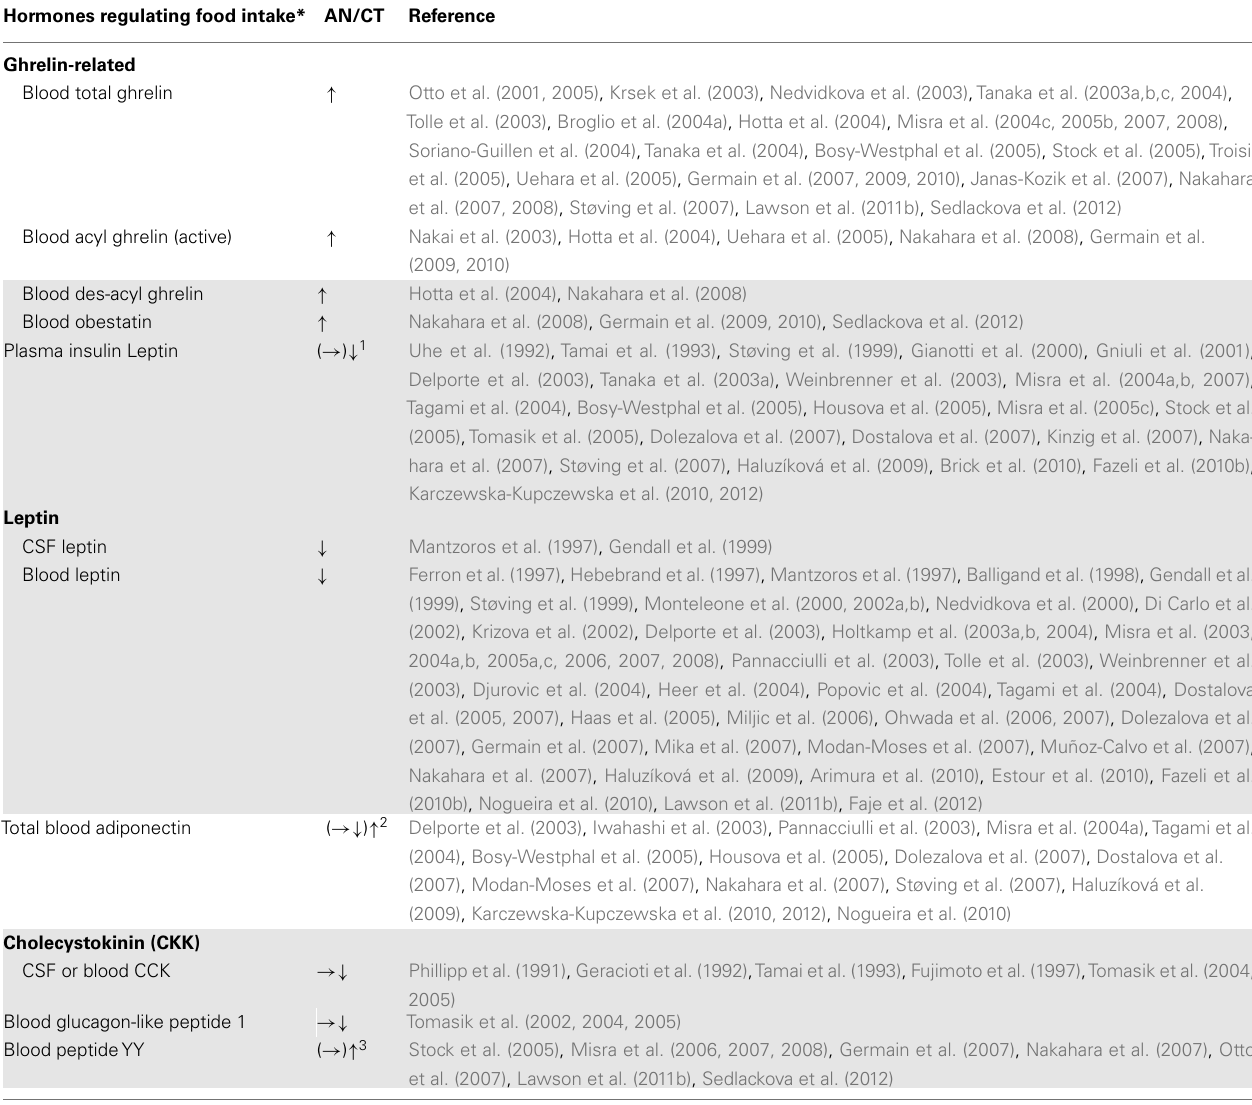
Table 4 | Compared levels of hormones regulating food intake inAN patients and healthy matched